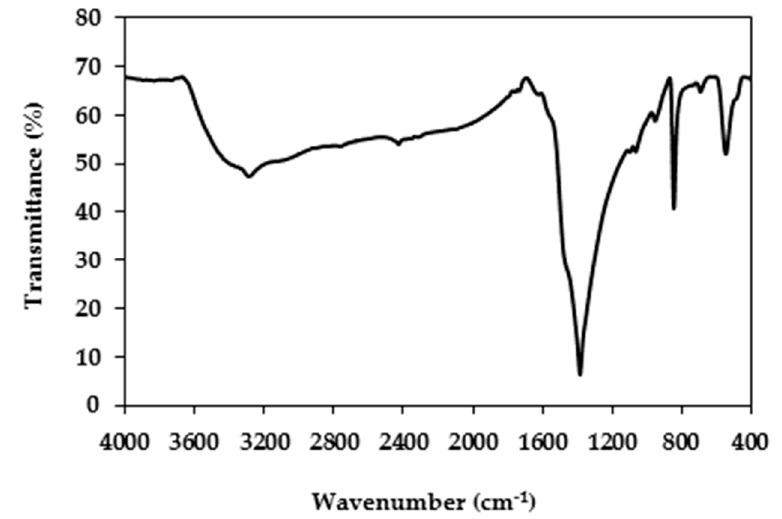
Figure 2. FTIR spectrum of the compound Bi 2 O 2 CO 3 :Al. Table 1. Main absorption bands in the IR of the compound Bi 2 O 2 CO 3 :Al.